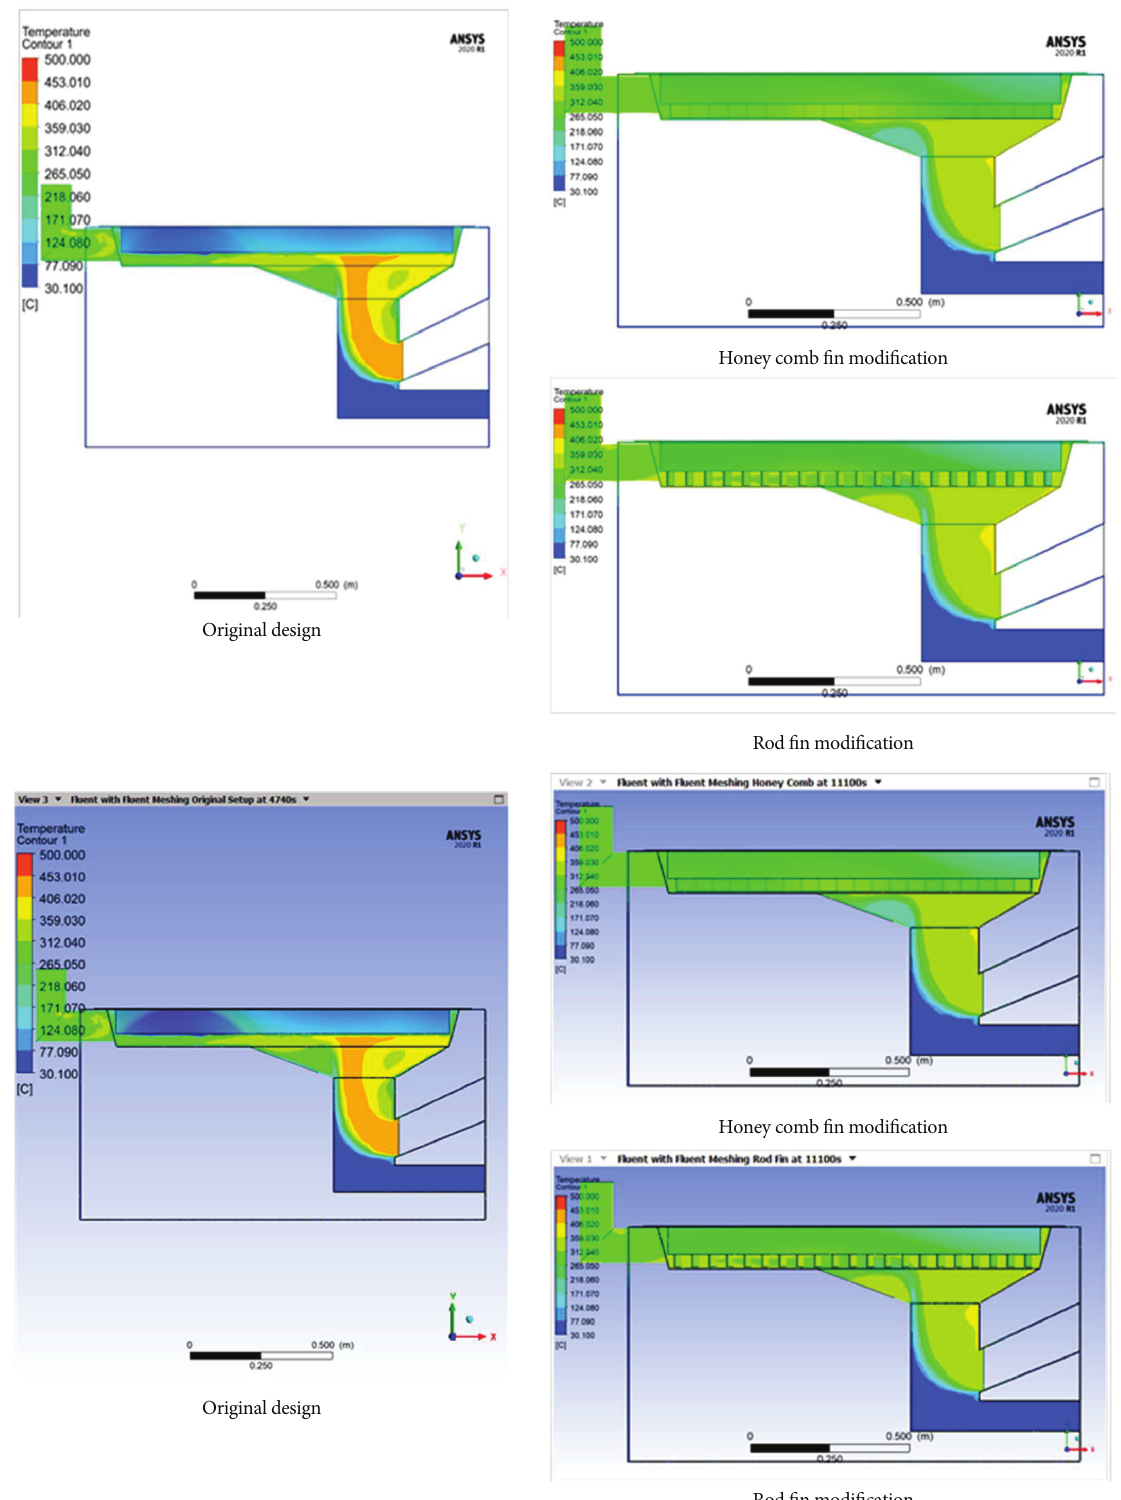
Figure 8: Temperature contour plot of a hot plate with different fin configurations (original plate without fins, hot plate with honeycomb fins, and hot plate with rod